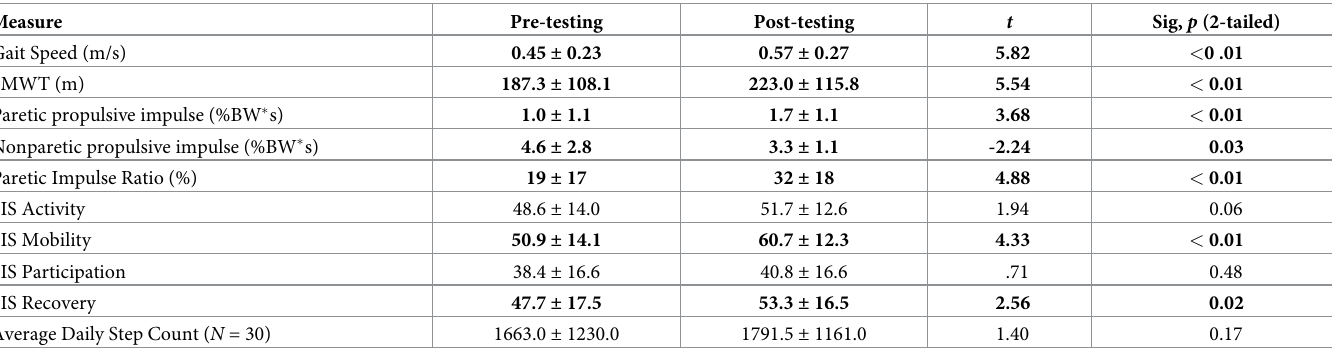
Table 3. Paired samples t-tests for outcome measures and propulsion measures ( N = 31).